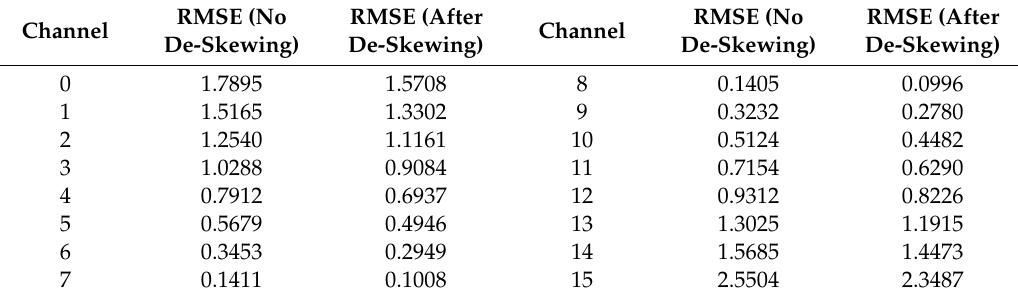
Figure 14. Errors changing by time. Table 1. Evaluation of channel accuracy in the indoor